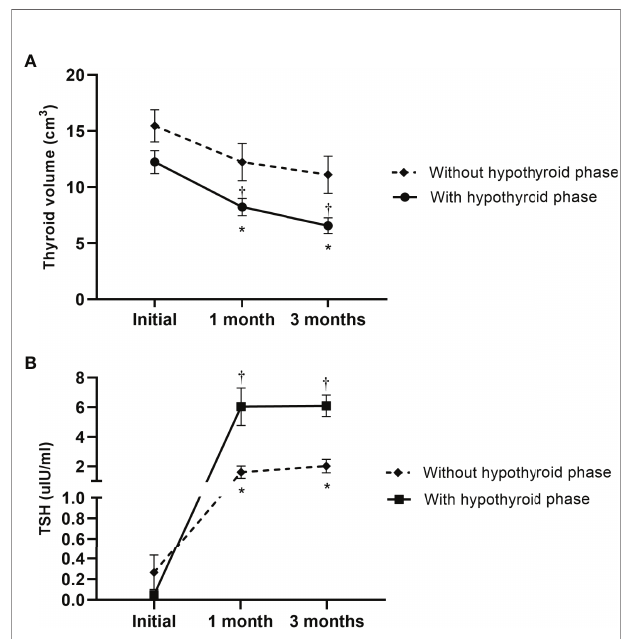
FIGURE 2 | The change in (A) thyroid volumes and (B) serum TSH levels in the time course of subacute thyroiditis patients, who were divided based on the development of hypothyroid phase in their clinical courses. Asterisks represent signi fi cant difference between the two subgroups, and daggers imply signi fi cant differences in the initial features of each subgroup.